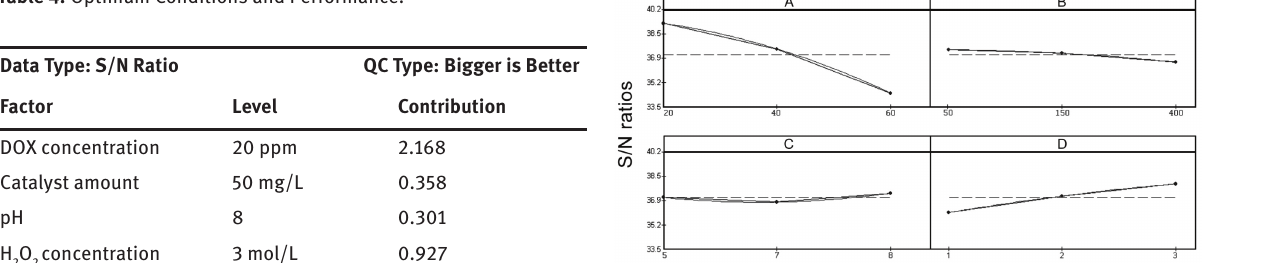
Table 4: Optimum Conditions and Performance.